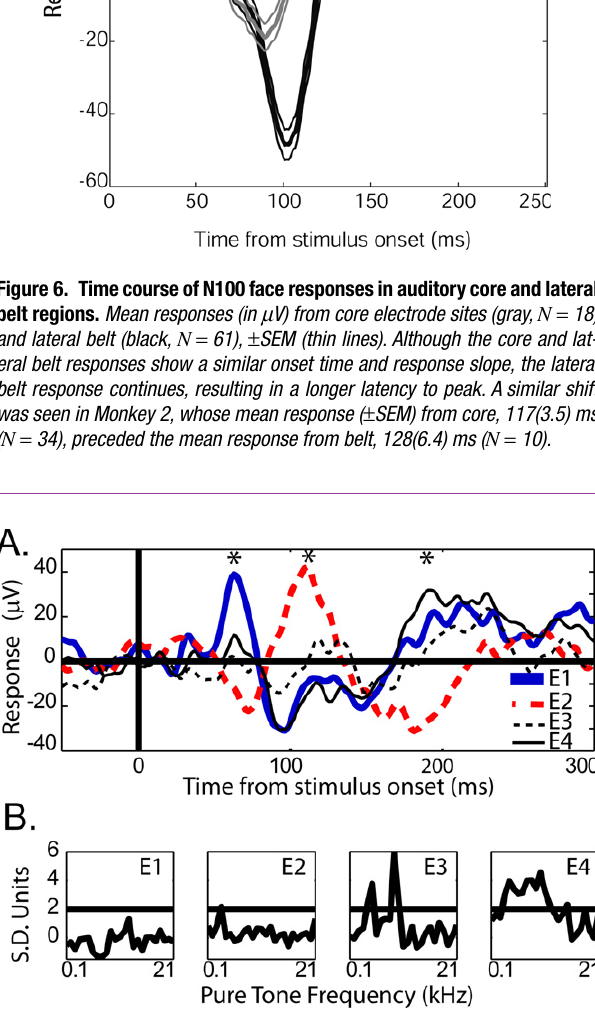
Figure 7. (A) Mean LFP responses from 4 simultaneously recorded electrode sites in auditory cortex. The response from each adjacent electrode site is plotted separately (see E1–E4 legend). Conventions are as in Figure 2 . The asterisks indicate alternating maxima of the polarity reversals between E1 and E2, the most posterior electrodes in the array. (B) Pure-tone frequency tuning curves for each electrode, 1–4,